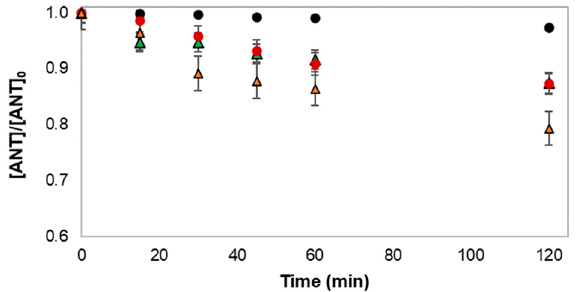
Figure 3. Photolysis under simulated solar radiation (43 W m − 2 , 290–800 nm) at 21 °C. Guarapiranga reservoir matrix (pH 7.2): ( ● ) FLX ( ) FLXSO 4 ; Pure water matrix (natural pH: FLX: ~6.7; FLXSO 4 : ~6.3): ( ● ) FLX ( ) FLXSO 4 . [ANT] 0 = (10.67 ± 0.49) mg L − 1 . Experiments were performed in duplicate.